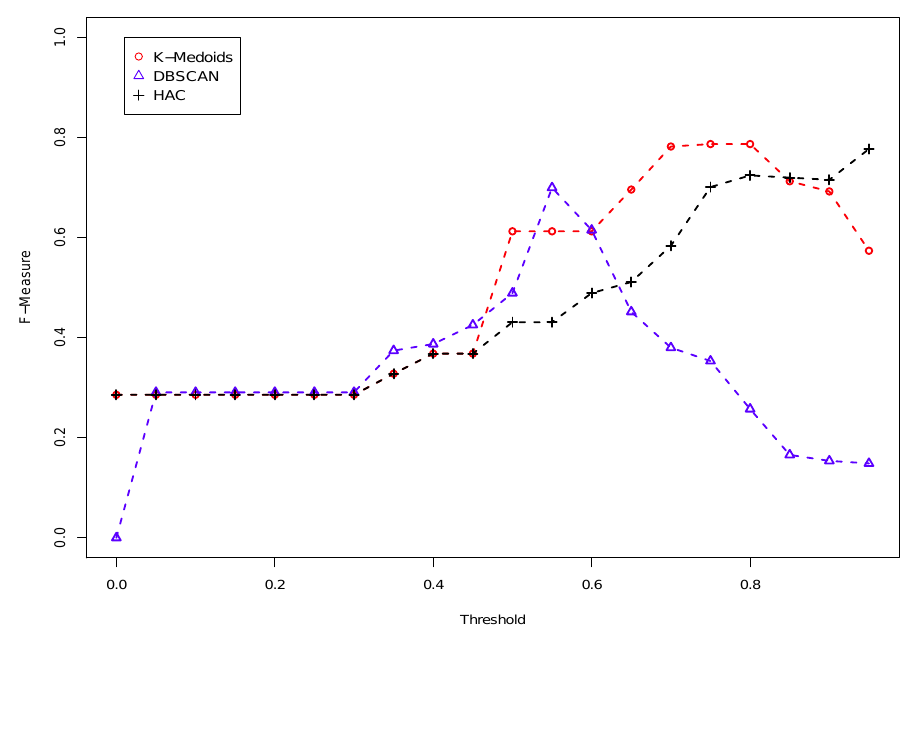
Figure 10. Clustering results using semantic dissimilarity, using vector word